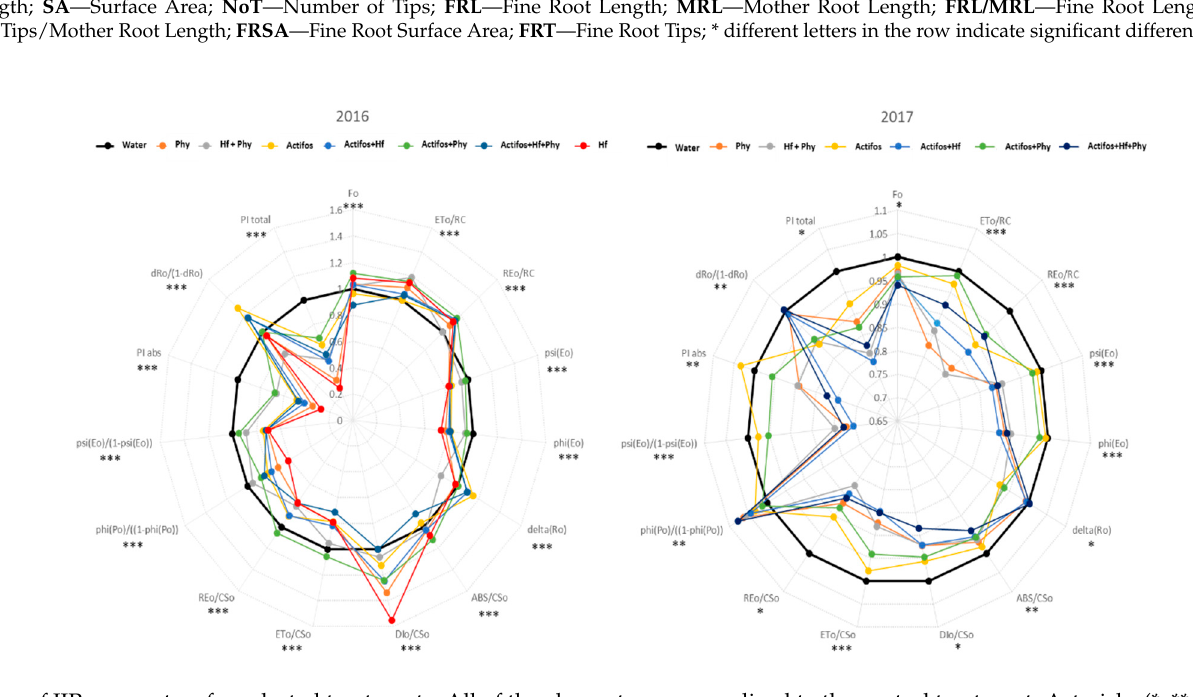
Figure 3. Comparison of JIP parameters for selected treatments. All of the elements are normalized to the control treatment. Asterisks (*, **, ***) denote significant differences between control and treated plants according to the Fisher LSD test at p ≤ 0.05, p ≤ 0.01, and p ≤ 0.001, respectively.